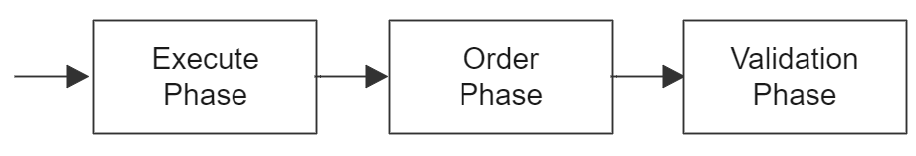
Figure 6. Execute-order-validate transaction processing